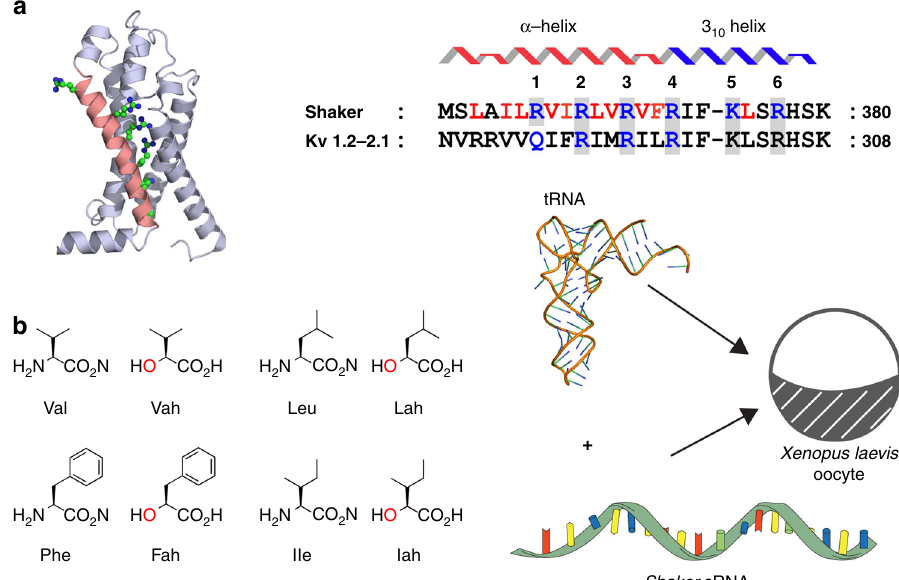
Fig. 1 Main chain mutagenesis in a voltage-gated potassium channel voltage-sensor. a Structure of the voltage-sensing domain (VSD) of the Kv1.2/2.1 chimera (pdb 2R9R). The S4-helix is in pink with side-chains for conserved Arg and Lys residues shown as sticks. Right, sequence alignments of the S4 sequence. Residues mutated in Shaker are shown in red. The α -helical (red) and 3 10 -helical (blue) regions in the Kv1.2/2.1 structure are shown above the alignment. b Structures of amino acids (aa) and α -hydroxy acids (ah): Vah hydroxyl-isovaleric acid, Lah 2-hydroxy-4-methylpentanoic acid, Fah 3- phenyl lactic acid, Iah 2-hydroxy-3-methylpentanoic acid. Right, these are ligated to the tRNAs (pdb 2ZNI) for nonsense suppression. Shaker cRNA containing a UAG stop codon at the suppression site is co-injected with an orthogonal amber (TAG) suppressor tRNA chemically ligated to an amino acid or α -hydroxy acid